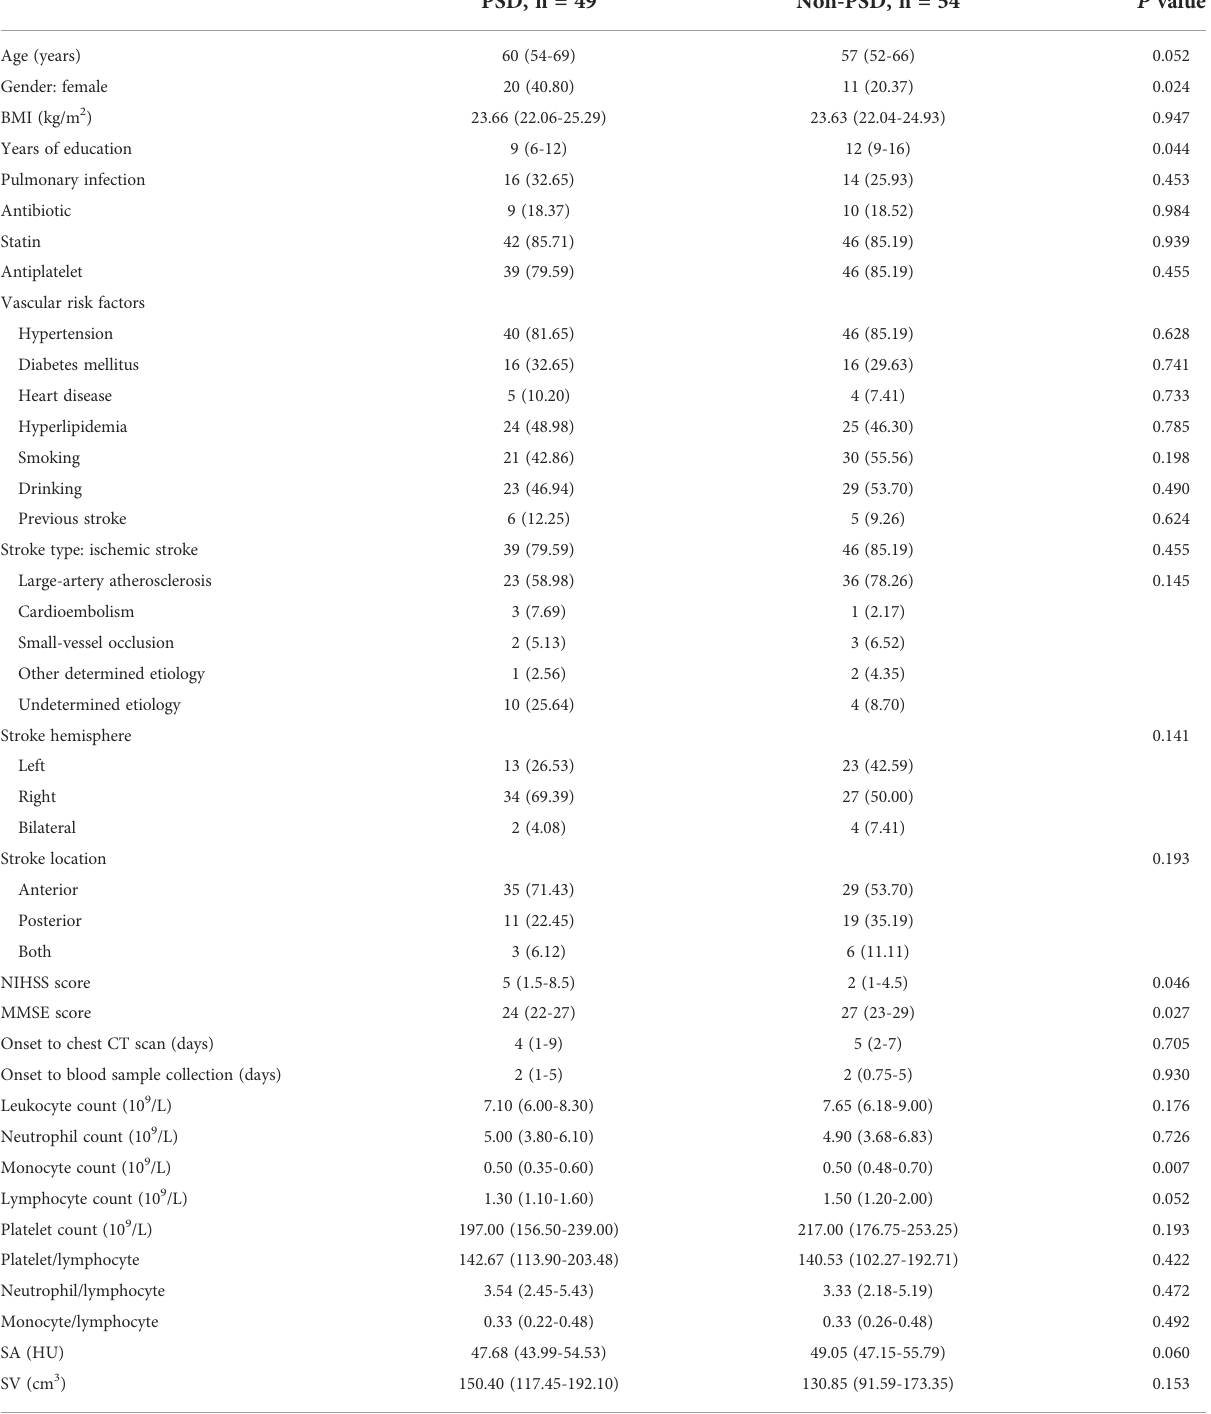
TABLE 1 Demographic and clinical characteristics of PSD and non-PSD